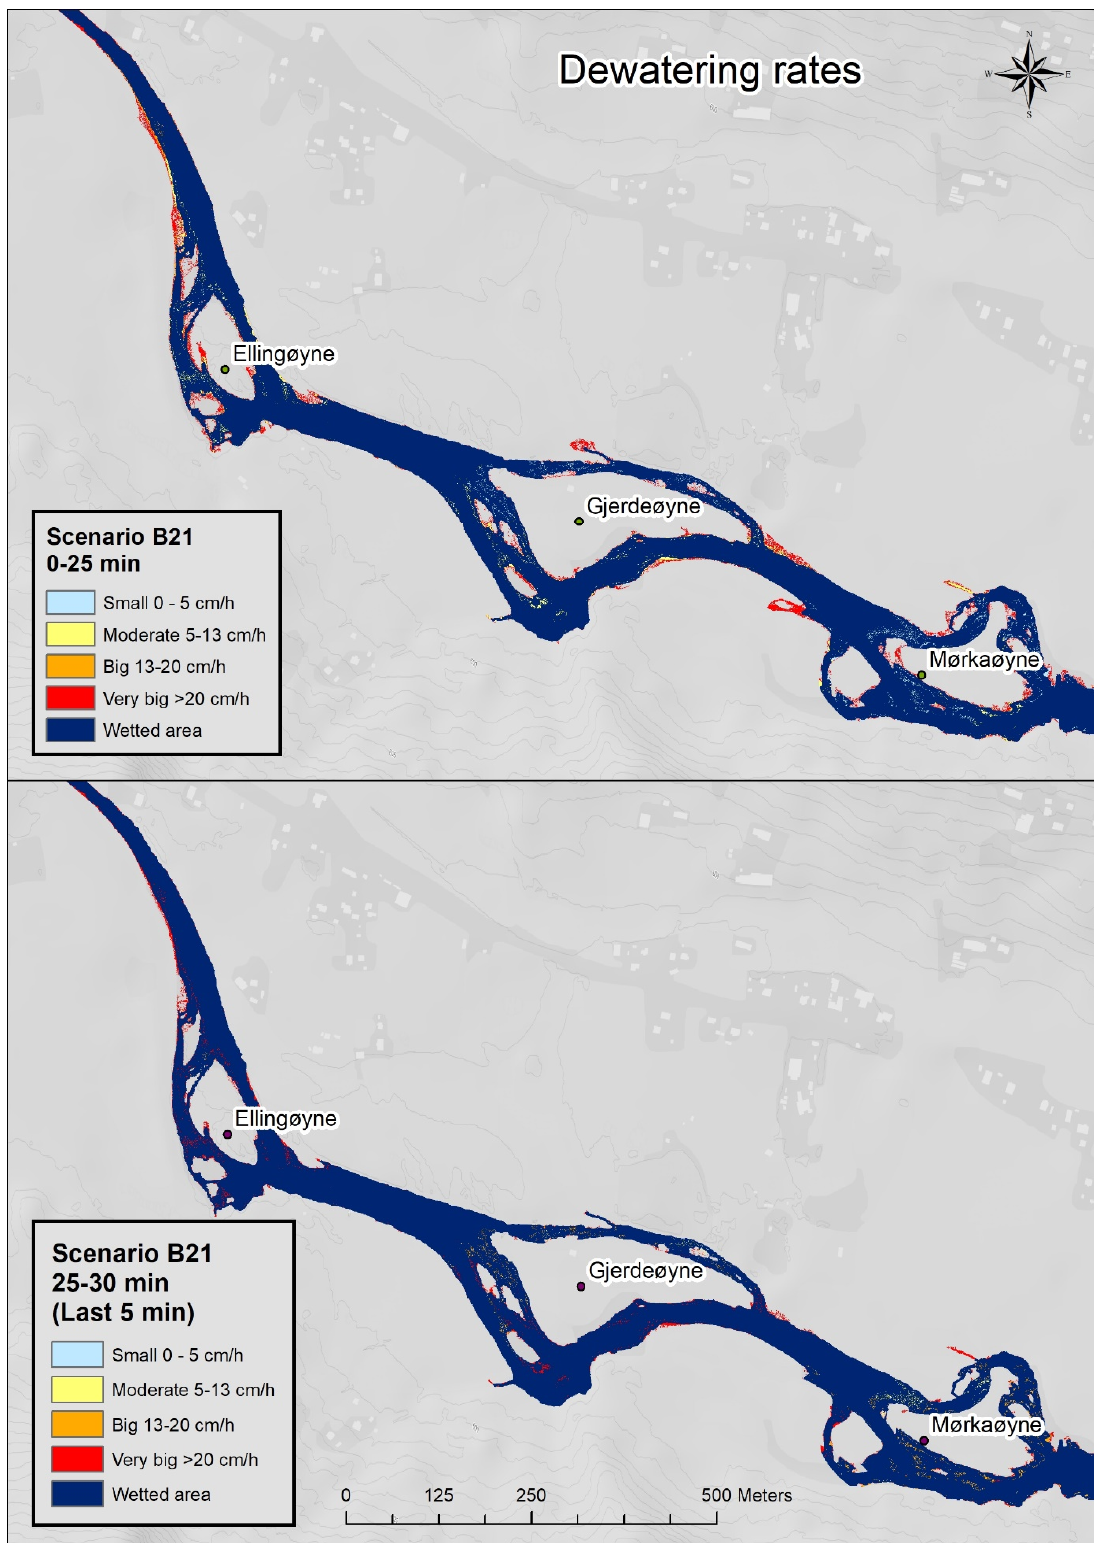
Figure A3. Dewatering rates scenario B21.